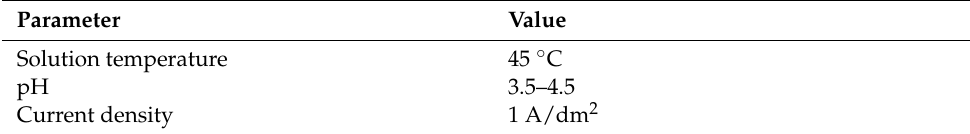
Figure 9. Schematic of experimental platform for ECD. Table 5. Experimental conditions for ECD.